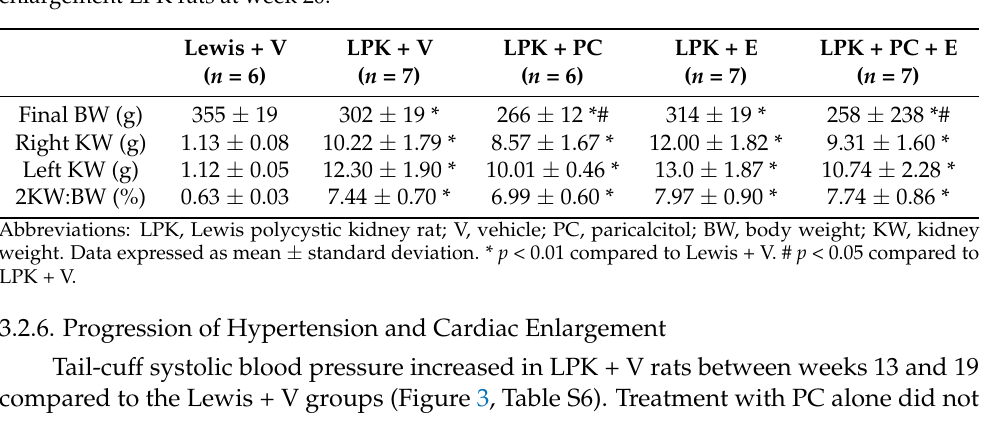
Table 4. Effect of delayed treatment of paricalcitol, enalapril and combination therapy on renal enlargement LPK rats at week